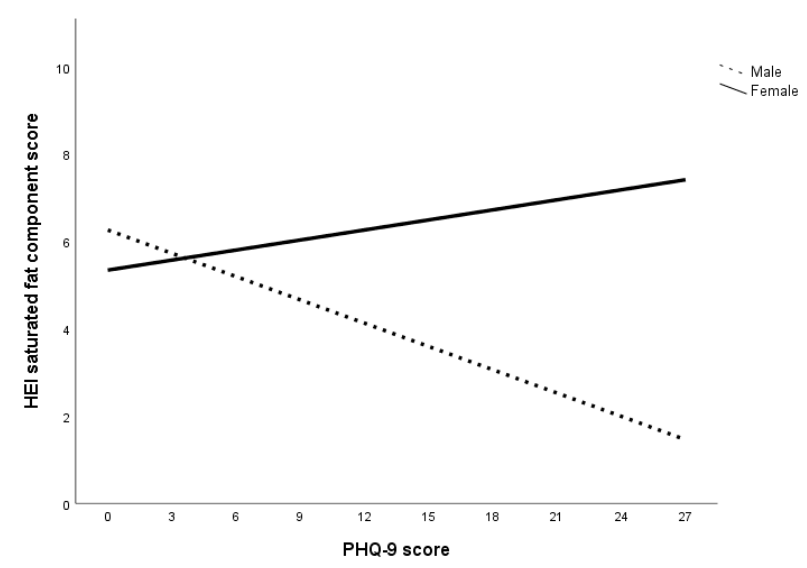
Figure 1. The relationship between depression and saturated fat consumption across sex. Note. Lower HEI saturated fat component score indicates higher consumption of saturated fat.